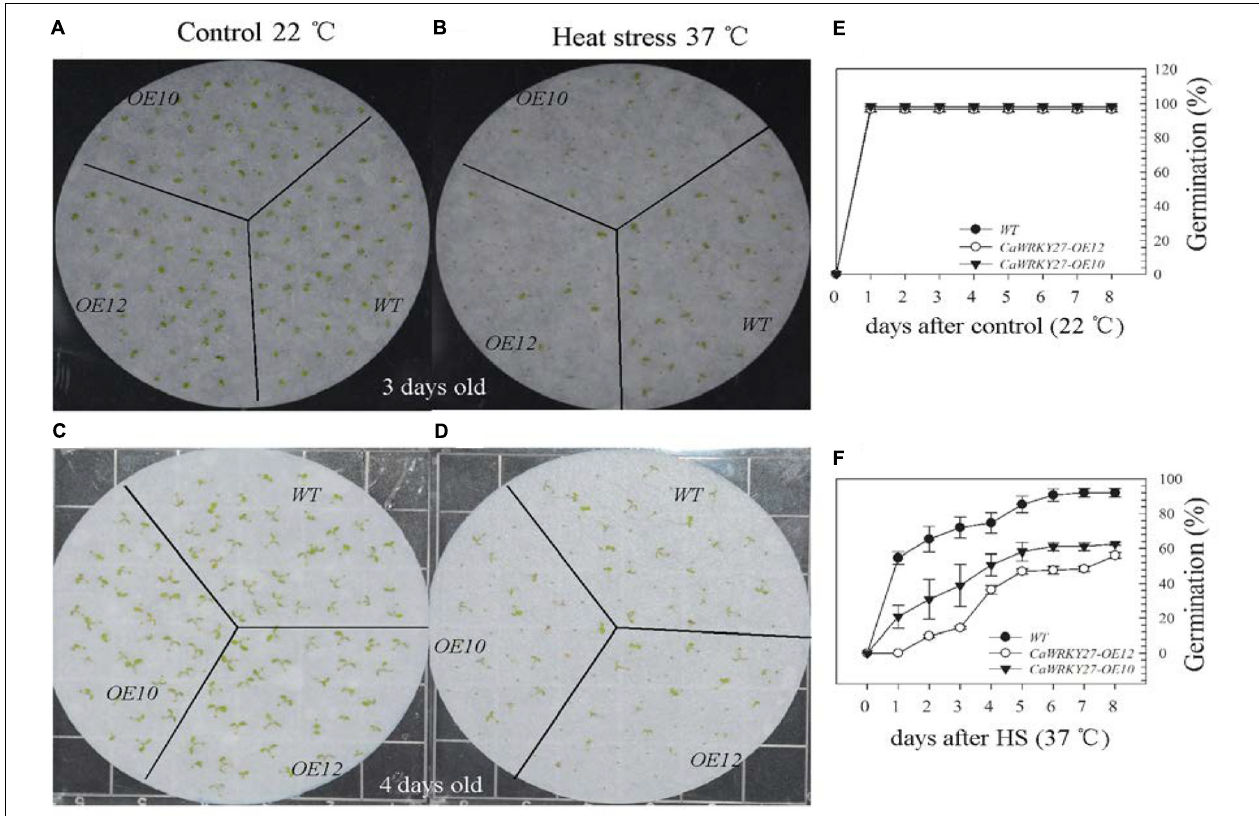
FIGURE 4 | Responses of WT and CaWRKY27 -overexpressing Arabidopsis lines to heat treatment during seed germination. (A–D) Illustration of representative seeds or seedlings at 3 or 4 days after heat treatment. (E,F) The percent of radicle emergence was recorded daily until no further radicles emerged in seeds of WT, CaWRKY27-OE10 , and OE12 plants. Seeds were treated at 37 ◦ C or at 22 ◦ C for the control. Data represent the mean ± SE ( n = 3), each replicate consists of 30 seeds.